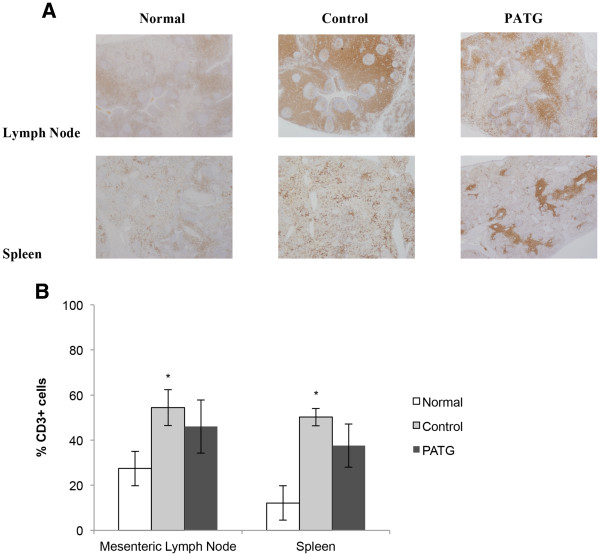
Central lymphocyte counts at time of necropsy. A) Representative immunohistochemistry images ofanti- CD3 stains for normal, control, and PATG tissue. B) Quantification of CD3+ reactivity by automated cellular Imaging. * indicates p < 0.05 compared to normal, unmanipulated tissue. Data is depicted as mean ± SEM.